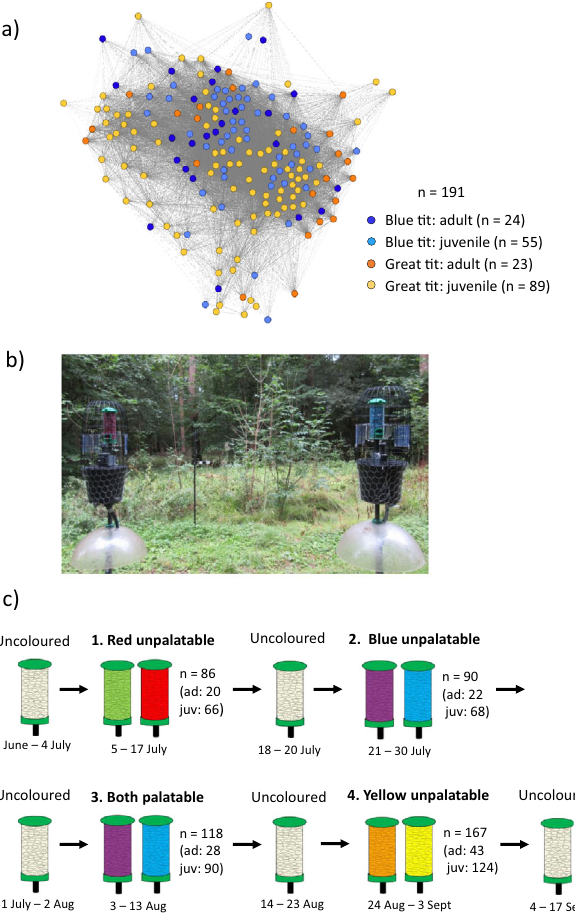
Fig. 1 Summary of the experiments. a The social network of the bird population was constructed based on the recorded associations outside the learning experiments. Nodes in the networks represent individual birds (adult blue tits = dark blue; juvenile blue tits = light blue; adult great tits = orange; juvenile great tits = yellow), and lines (edges) their associations in the network. b In each experiment, we had three feeding stations where birds were presented with a choice of two feeders with differently colored almonds. c Throughout the summer, we conducted three avoidance learning experiments with different color pairs (red/green, blue/purple, yellow/orange), and a reversal-learning experiment where both colors (blue/purple) were palatable. Between the learning experiments, birds were offered plain (palatable and uncolored) almond fl akes to collect information on their foraging associations.